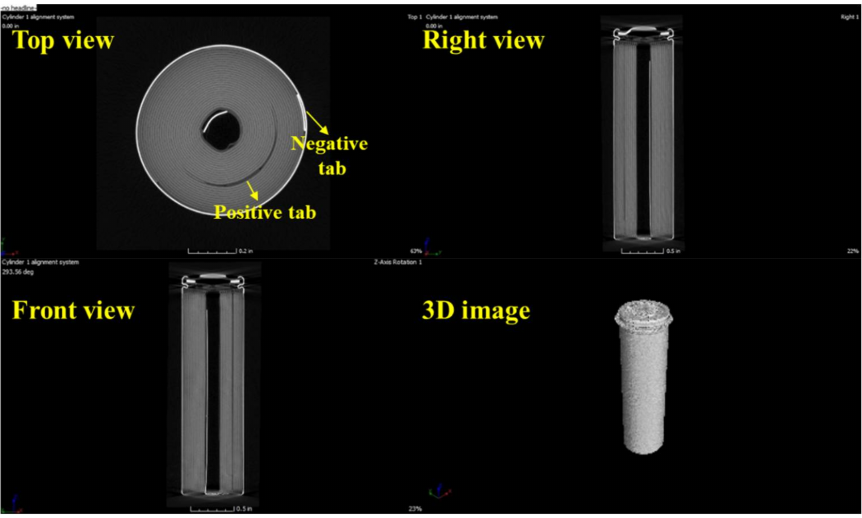
Figure 13. CT scan of the sample